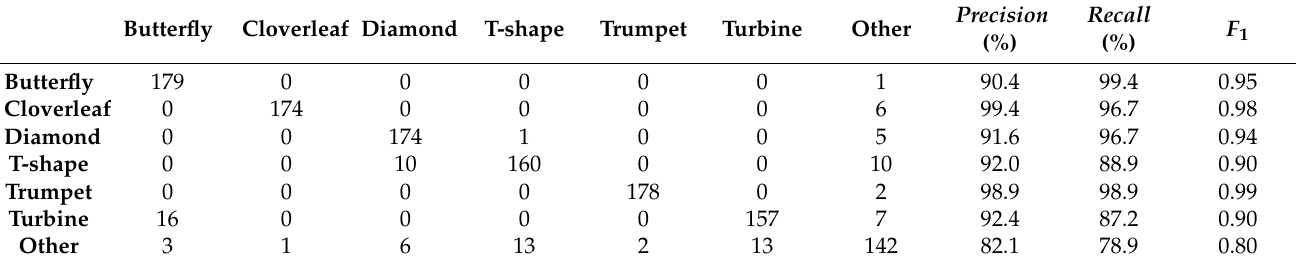
Table 5. Confusion matrix and evaluation metrics of the classification results of complex junctions using the GoogLeNet-based SE